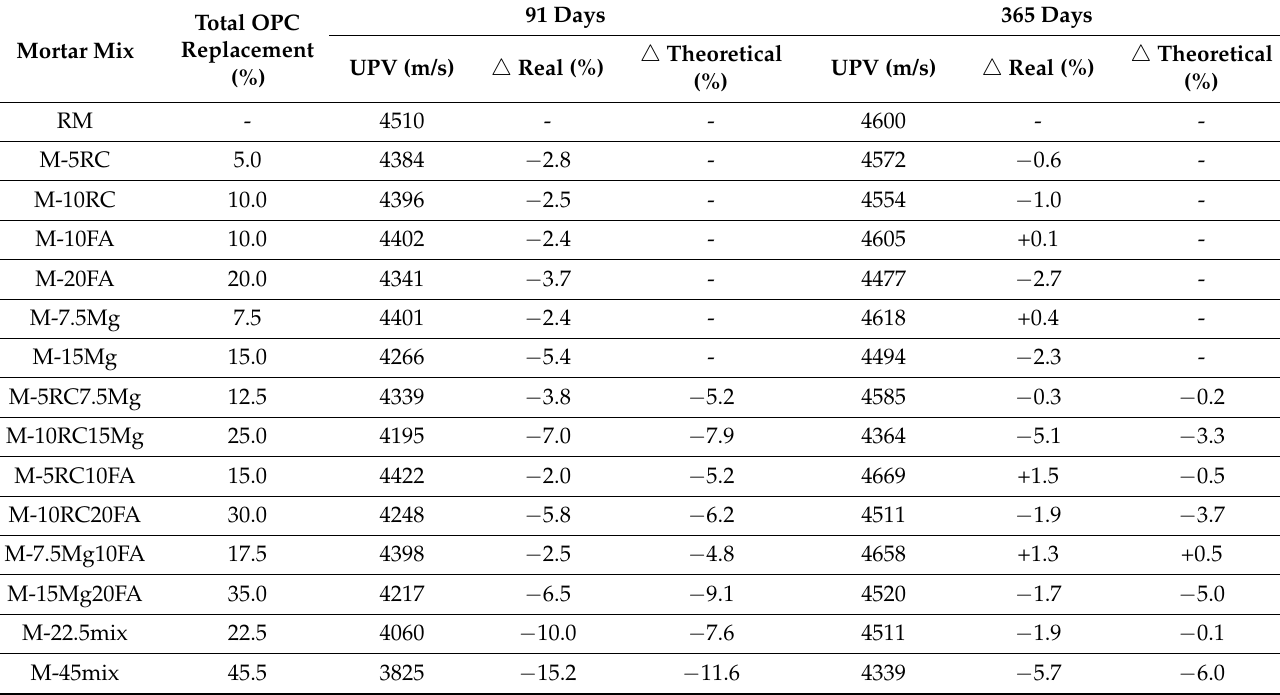
Table 9. Ultrasonic pulse velocity between 91 and 365 days.